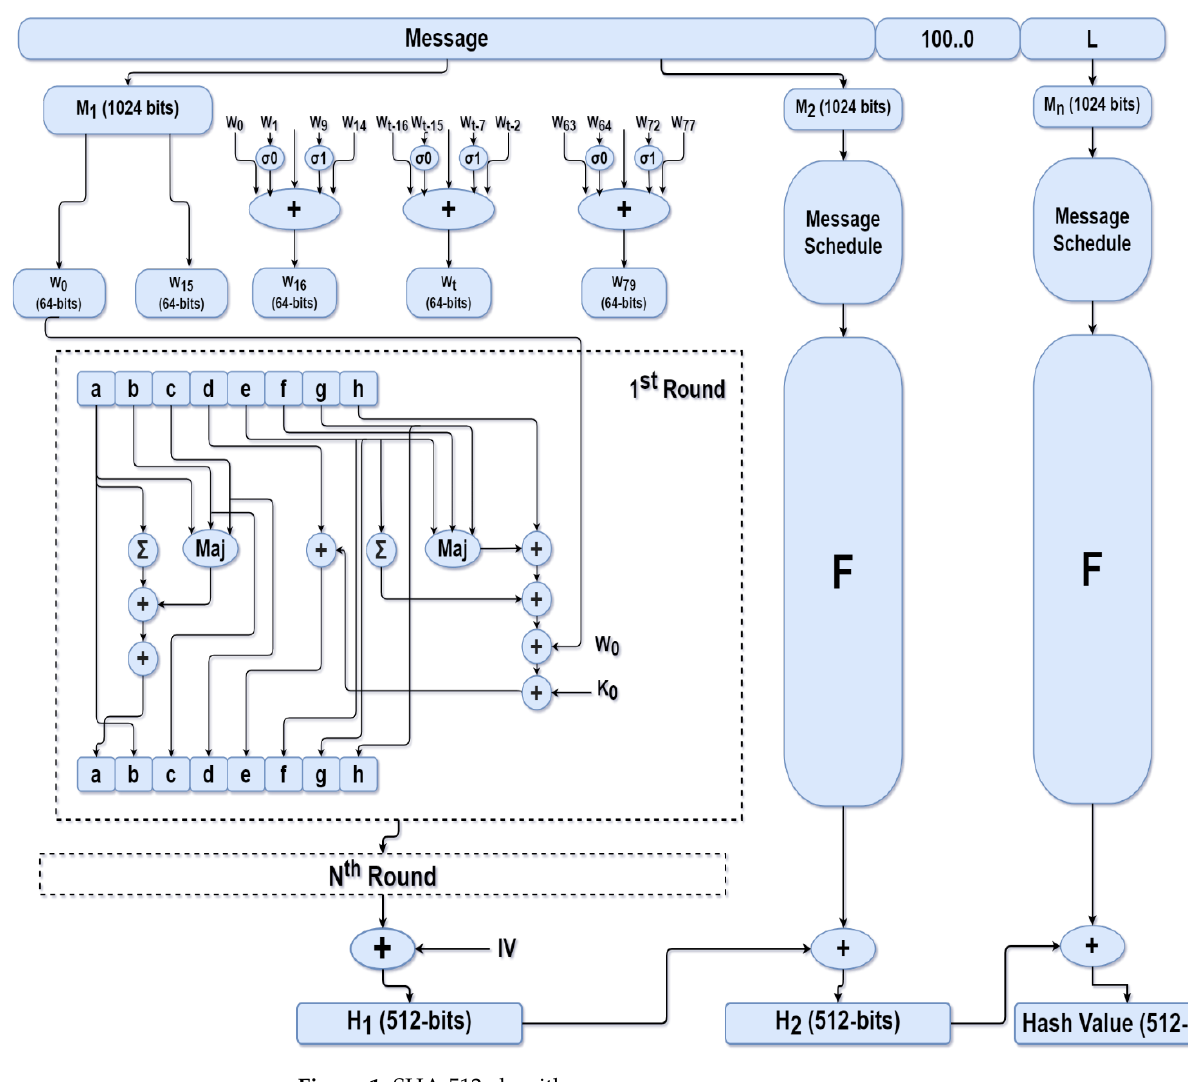
Figure 1. SHA-512 algorithm.